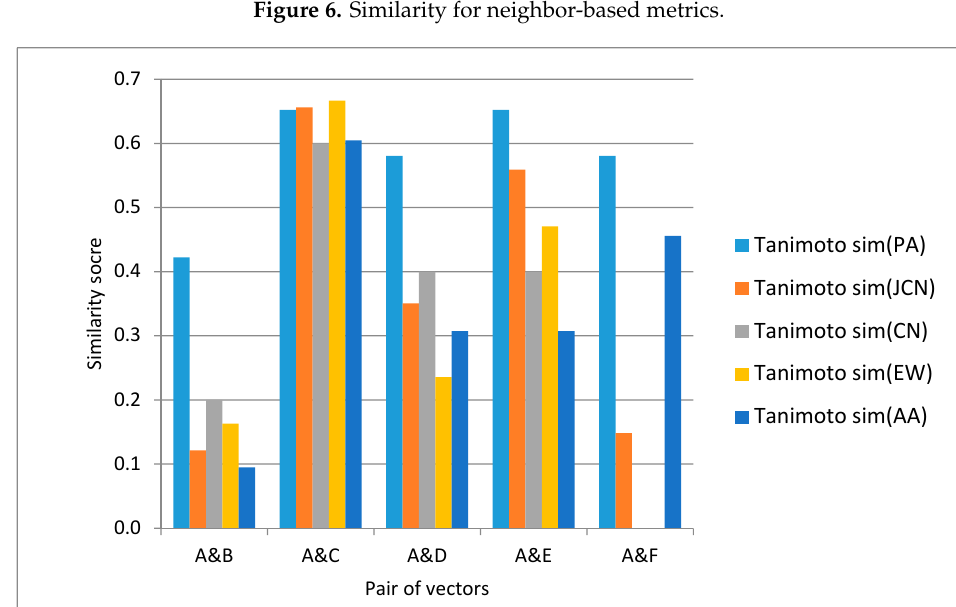
Figure 6. Similarity for neighbor-based metrics.